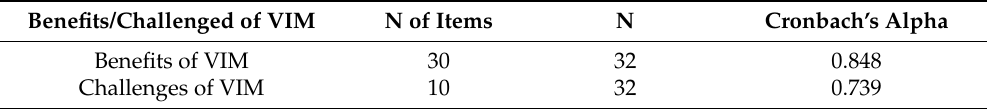
Table 4. Reliability of Survey: Cronbach’s Alpha